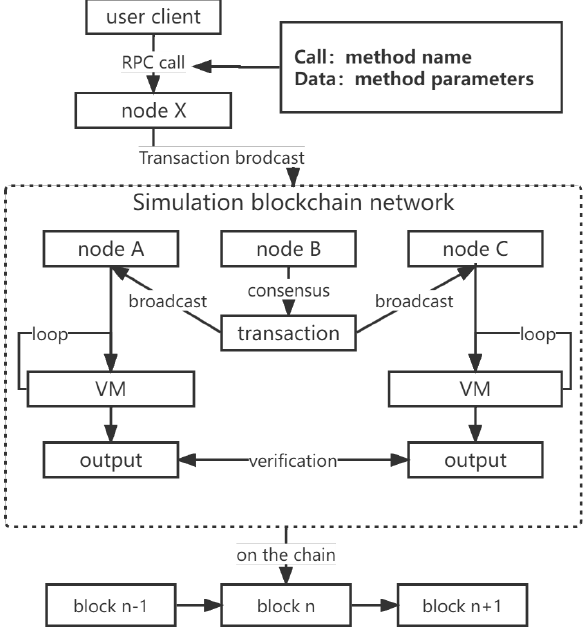
Figure 2. Flowchart of the blockchain simulation system’s overall